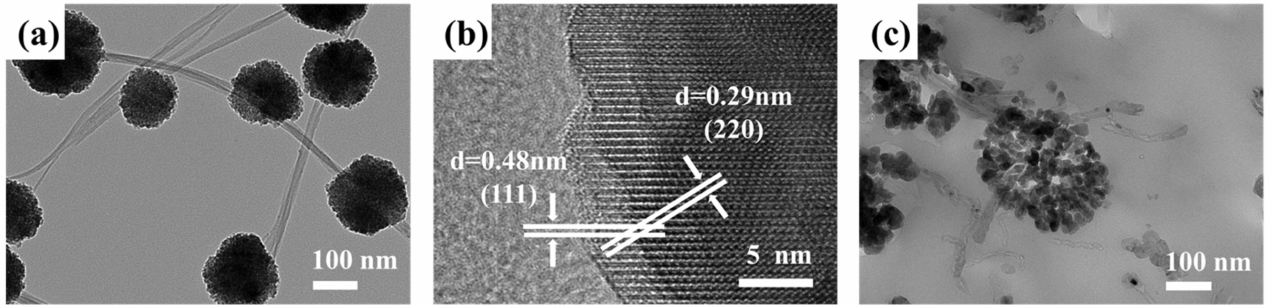
Figure 5. ( a ) TEM image of Fe 3 O 4 /MWCNT, ( b ) HRTEM image of Fe 3 O 4 /MWCNT and ( c ) TEM image of microtomed Fe 3 O 4